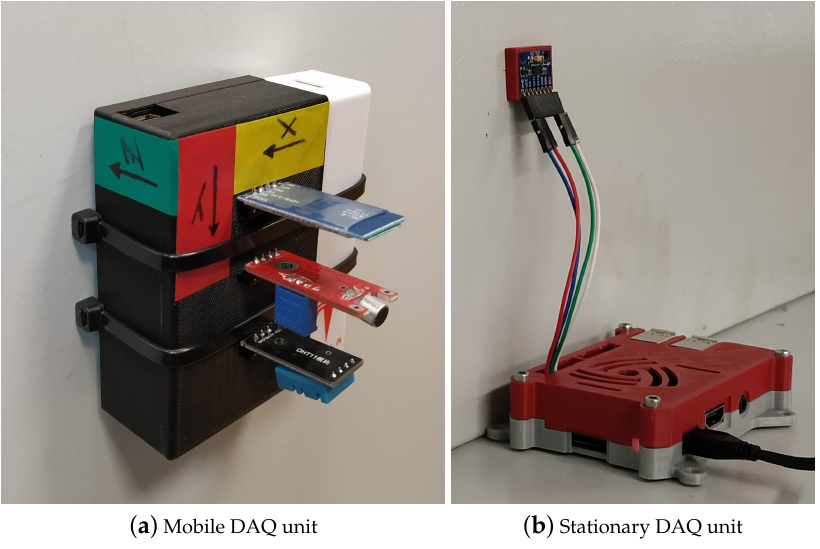
Figure 4. Different types of retrofitting Industry 4.0 sensor